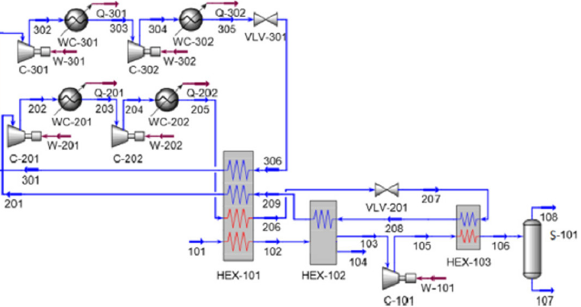
Figure 54. CH 4 -C 2 H 4 PLNG process with CO2 cryogenic removal [207].